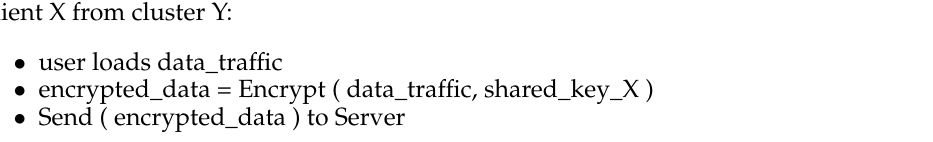
Algorithm 1 Consensus algorithm regarding traffic